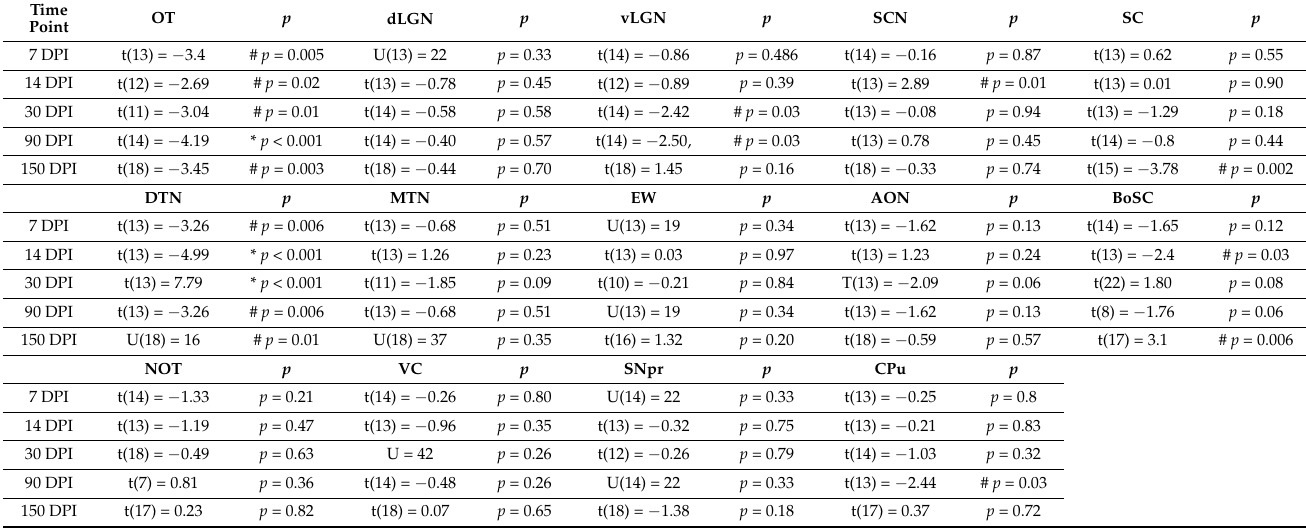
Table 4. Statistics for IHC—IBA-1 (Soma